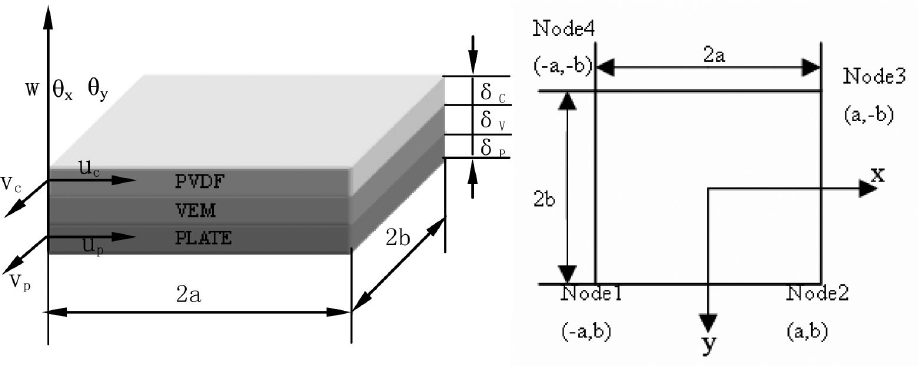
Fig. 1. A schematic drawing of an element in FE structure of plate with CLD